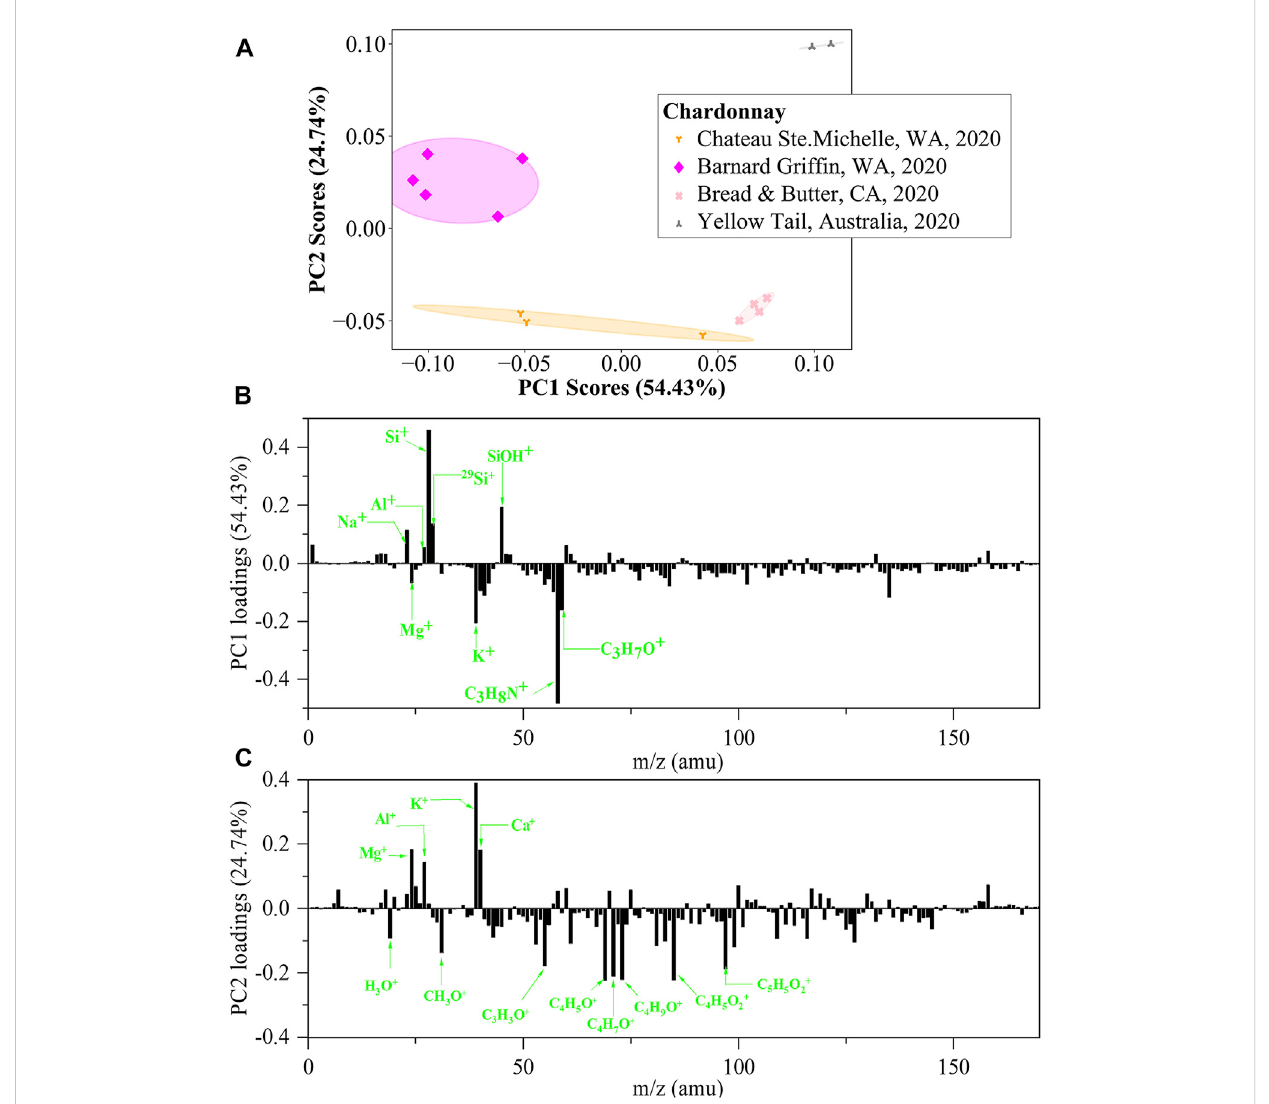
FIGURE 7 PCAanalysisof insitu liquidSIMSspectrafromthefourChardonnaywinesinpositiveionmode. (A) Scoresplotofthe fi rstprincipalcomponent(PC1) versus the second principal component (PC2) from the spectra of in situ liquid SIMS. (B) Corresponding loadings plot of PC1 and (C) Corresponding loadings plot of PC2. Note: no signi fi cant loadings were observed over m/z